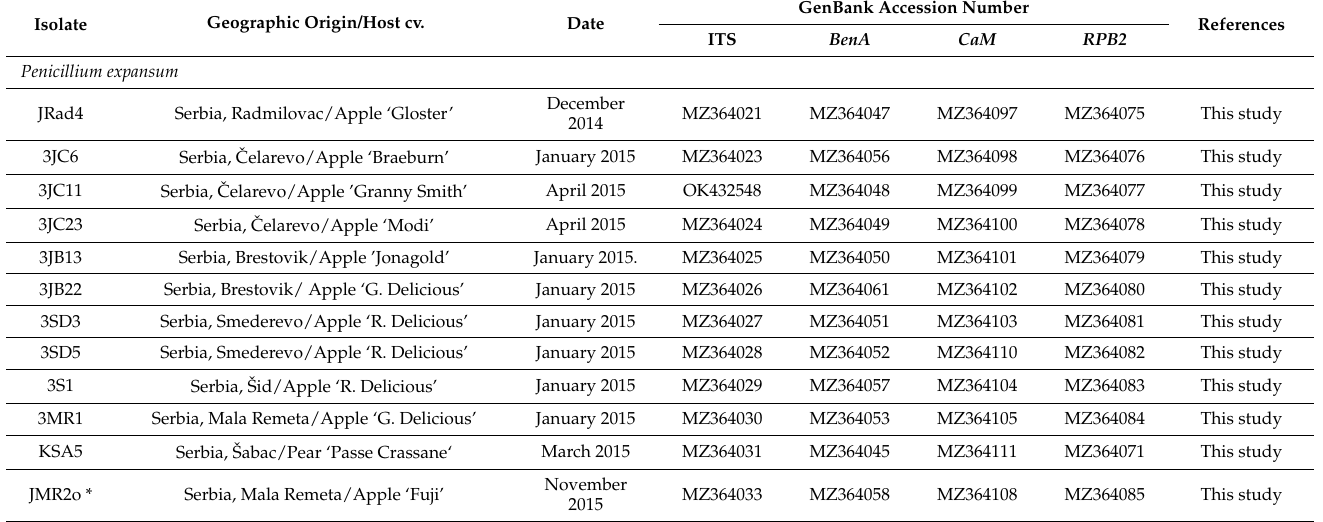
Table 1. Isolates used in this